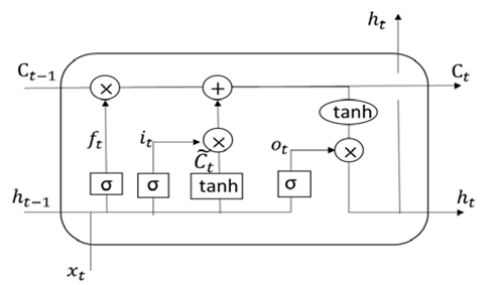
Figure 3. LSTM representation.